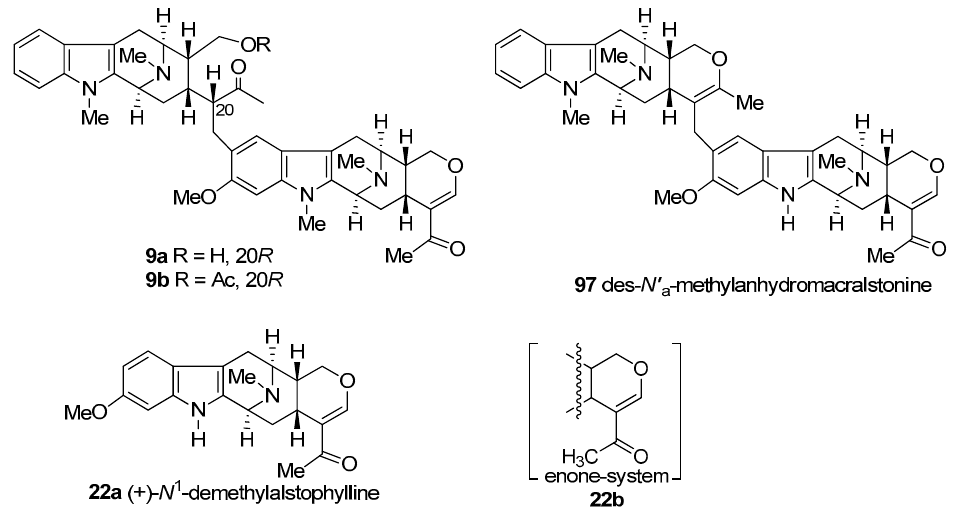
Figure 7. Structures of the cyclic ketone form ( 9a ) of (+)-macralstonine and its O -acetyl derivative ( 9b ); des- N ′ a -methylanhydromacralstonine ( 97 ) as well N 1 -demethylalstophylline ( 22a ), and the enone system ( 22b ).